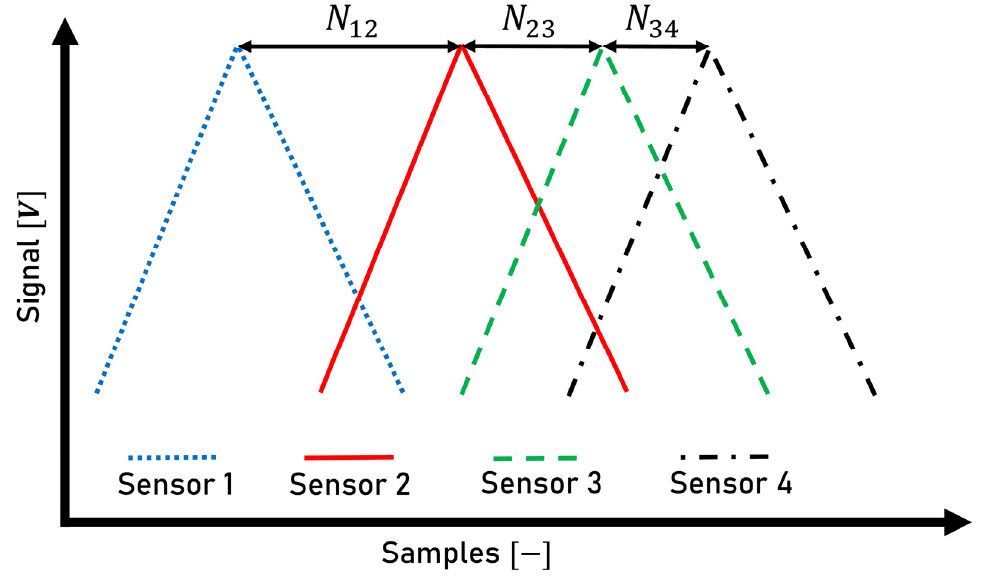
Figure 2. The phase shift of the four ‐ sensor setup. The phase shift (number of data points) between the respective sensors is marked with the parameters 𝑁 (cid:2869)(cid:2870) , 𝑁 (cid:2870)(cid:2871) and 𝑁 (cid:2871)(cid:2872) . To determine the phase shift, the PCC (Phase Cross ‐ Correlation) described by Schimmel [23] can be used, which was originally intended for an application in seismology. The basis is the theoretical assumption that all four sensors measure an identical profile on the same line with minor deviations to successfully achieve a correlation. Before determining the phase shift, the data are filtered with a high ‐ pass filter to remove the long ‐ wave components of the signals. If all known parameters are applied, this results in the velocity 𝑣 :